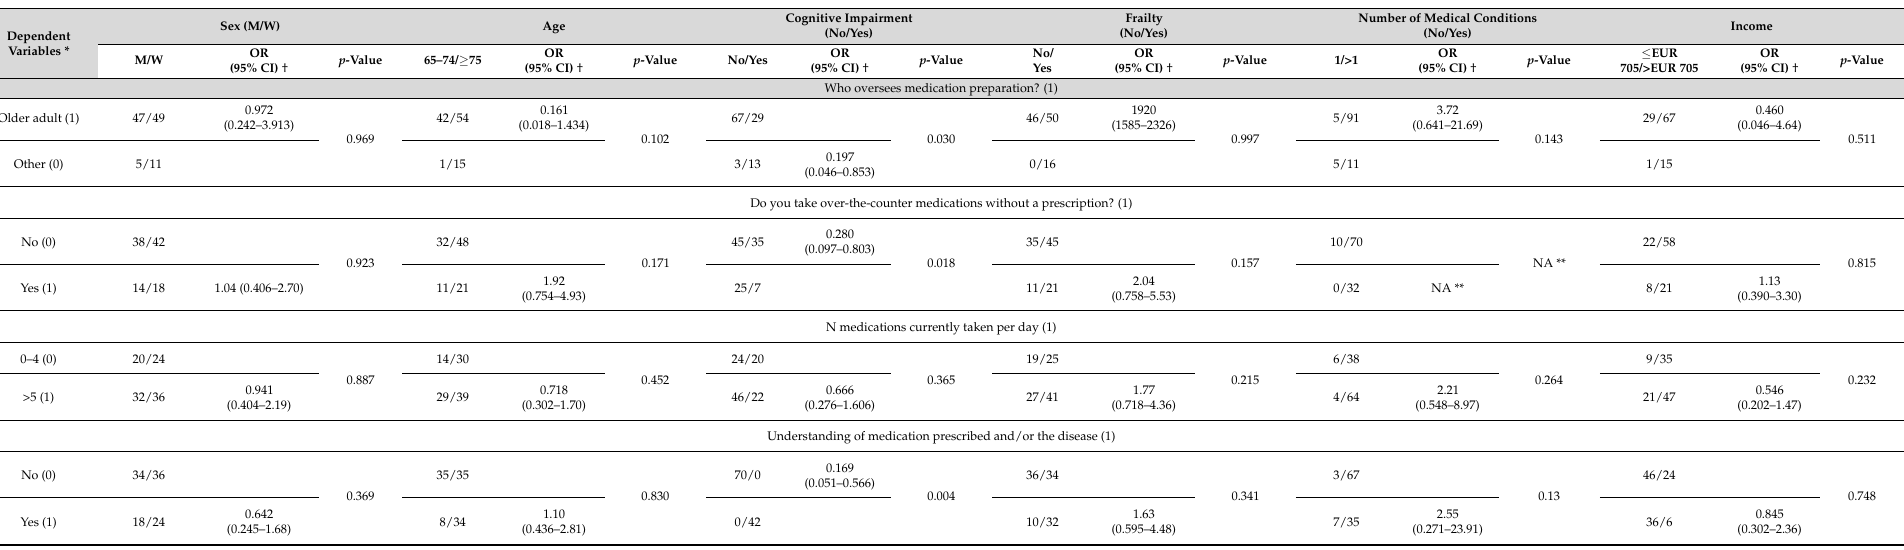
Table 4. Binary logistic regressions of medication management patterns and sociodemographic and clinical characteristics ( n =